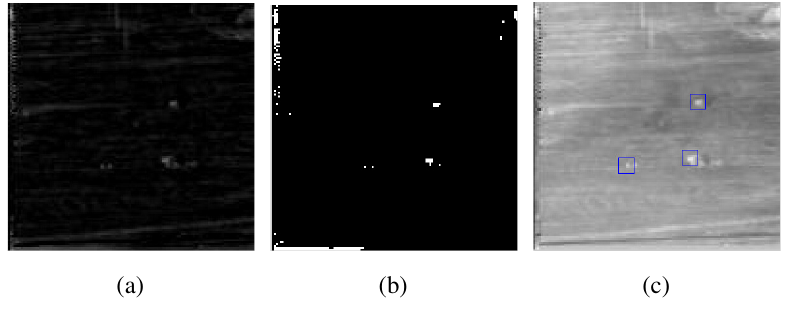
Figure 4. Figures of top-hat. ( a ) saliency map of top-hat method; ( b ) result of threshold operation; ( c ) final result marked by blue block.